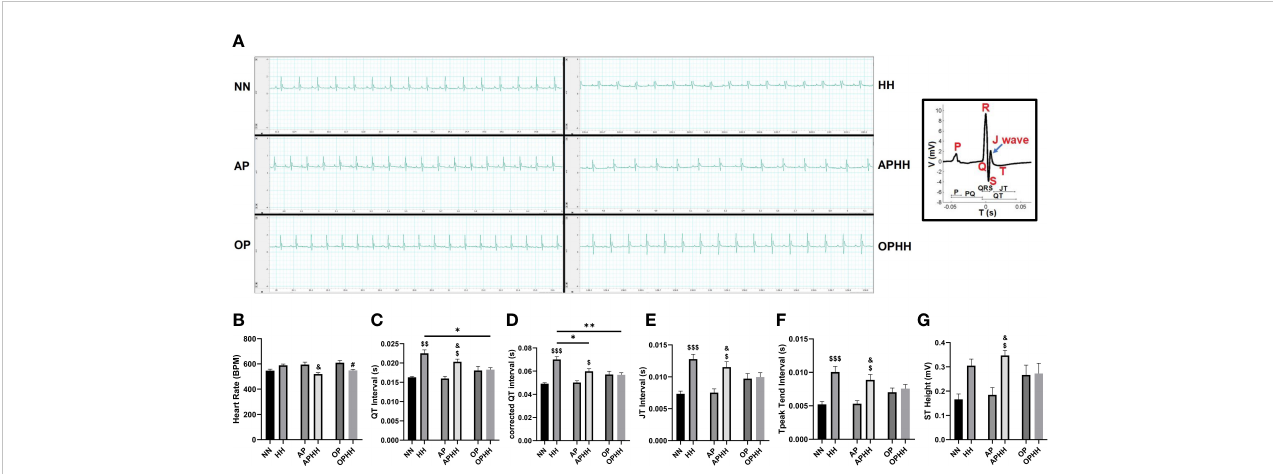
FIGURE 1 OP preserves cardiac electric activity during hypobaric hypoxia. (A) Representative electrocardiography (EKG) of Normobaric Normoxia (NN), Hypobaric Hypoxia (HH), Altitude Preconditioned (AP), Altitude Preconditioned before HH exposure (APHH), Occlusion Preconditioned (OP) and Occlusion Preconditioned before HH exposure (OPHH) mice. P wave: atrial depolarization; Q wave: Interventricular septum depolarization; R wave: Ventricular depolarization; S wave: Purkinje fi bres depolarization; J wave: Early ventricular repolarization; T wave: End of ventricular repolarization. (B-G) Graphical presentation of EKG parameters including; Heart Rate (HR), QT Interval, corrected QT Interval (QTc), JT Interval, Tpeak Tend Interval, and ST Height. (n= 5-9 mice per experimental group). $ p<0.05, $$ p<0.01, $$$ p<0.001 HH vs NN; & p<0.05 APHH vs AP; # p<0.05 OPHH vs OP; *p<0.05, **p<0.01. Data are expressed as mean ± SEM. Data were analyzed using one-way ANOVA, followed by Tukey ’ s post hoc